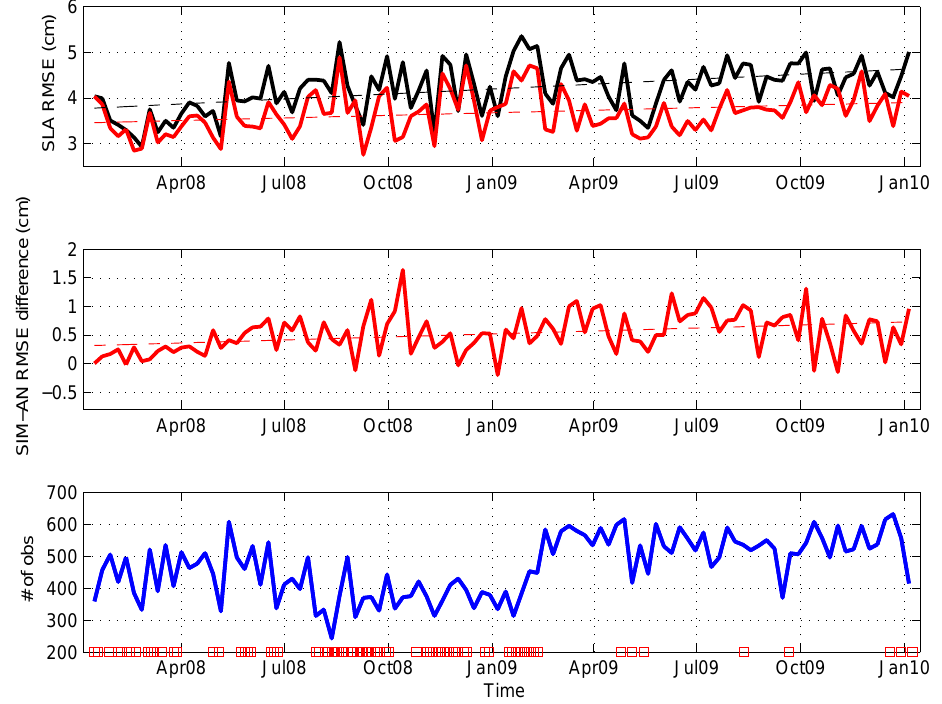
Fig. 2. Top panel: RMSE of SLA misfits with observations for AN background (red) and SIM (black). The respective trends are also plotted (dashed lines); Central panel: Differences between RMSE curves: SIM-AN and relative trend; Bottom panel: number of observations assimilated. Days with no observations to be assimilated are also indicated along the x-axis with red squares. RMSE values are weekly averages while the weekly sum was calculated for the number of observations.